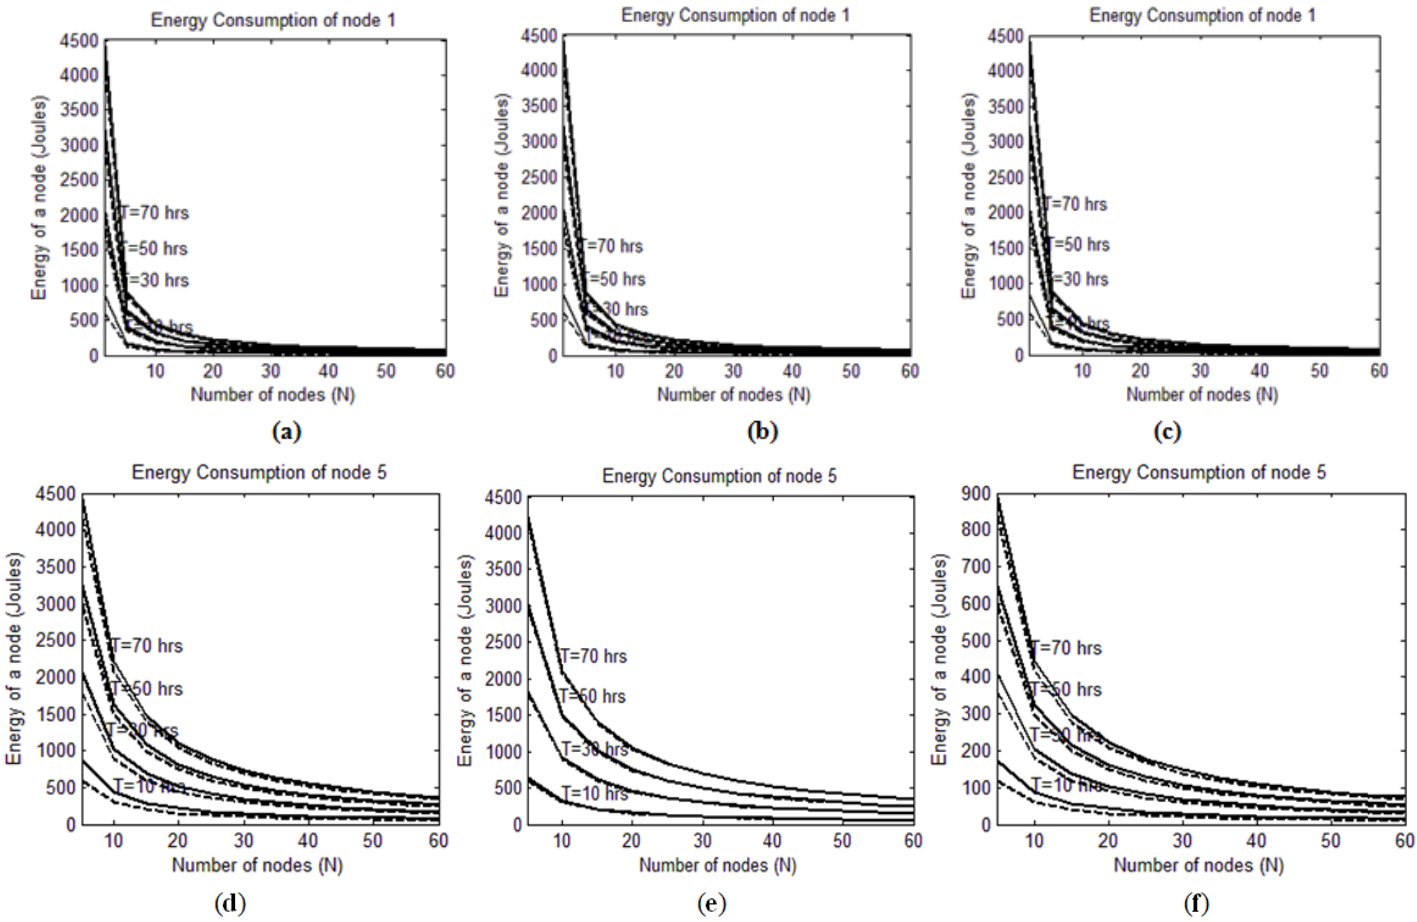
Figure 4. Energy consumption analysis results for ( a ) Location-based wakeup (1st node); ( b ) Time-based wakeup (1st node); ( c ) Interrupt-driven wakeup (1st node); ( d ) Location-based wakeup (5th node); ( e ) Time-based wakeup (5th node); ( f ) Interrupt-driven wakeup (5th node); ( g ) Location-based wakeup (25th node); ( h ) Time-based wakeup (25th node); ( i ) Interrupt-driven wakeup (25th node); ( j ) Location-based wakeup (50th node); ( k ) Time-based wakeup (50th node); ( l ) Interrupt-driven wakeup (50th